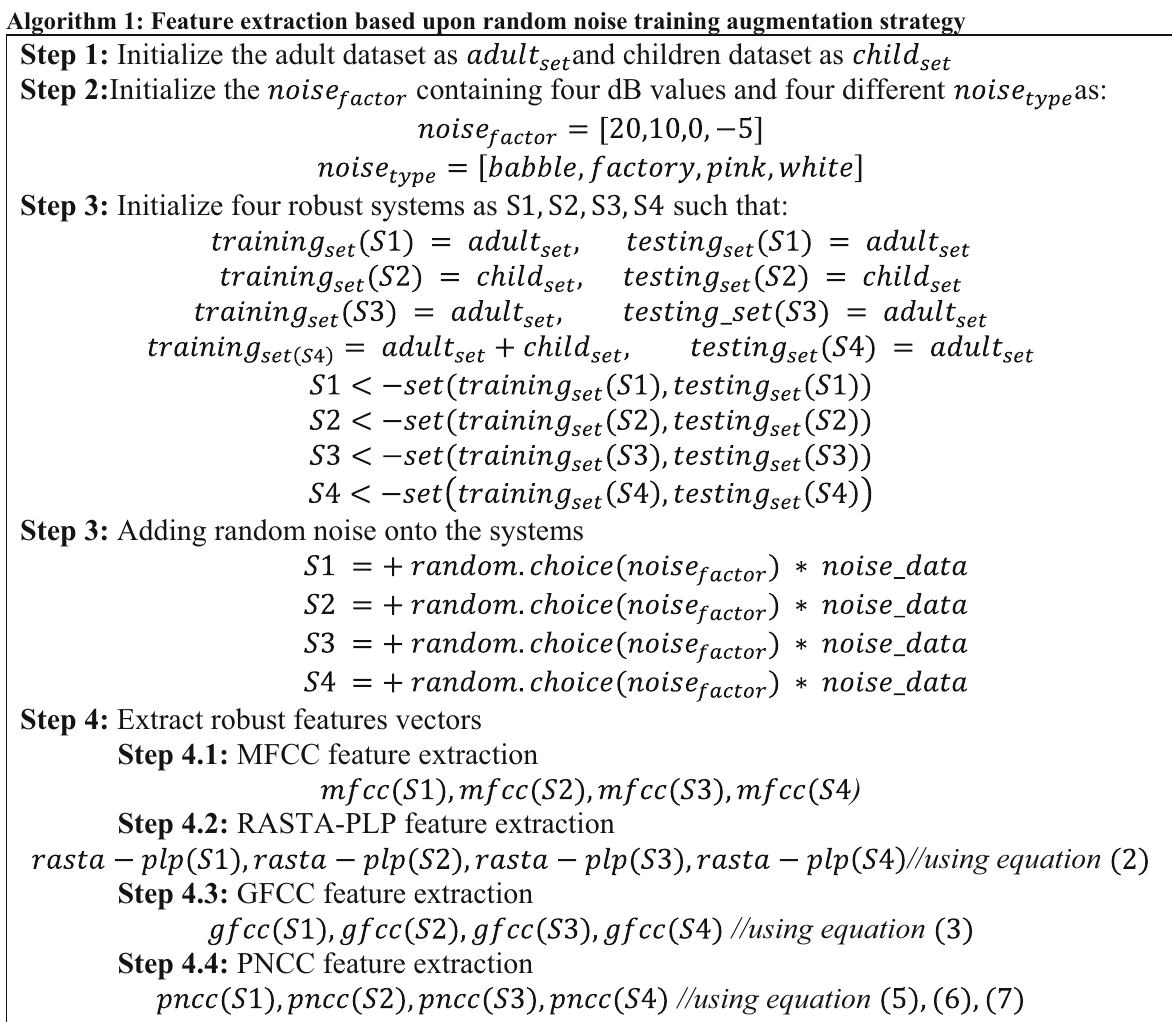
Algorithm 1: Feature extraction based upon random noise training augmentation